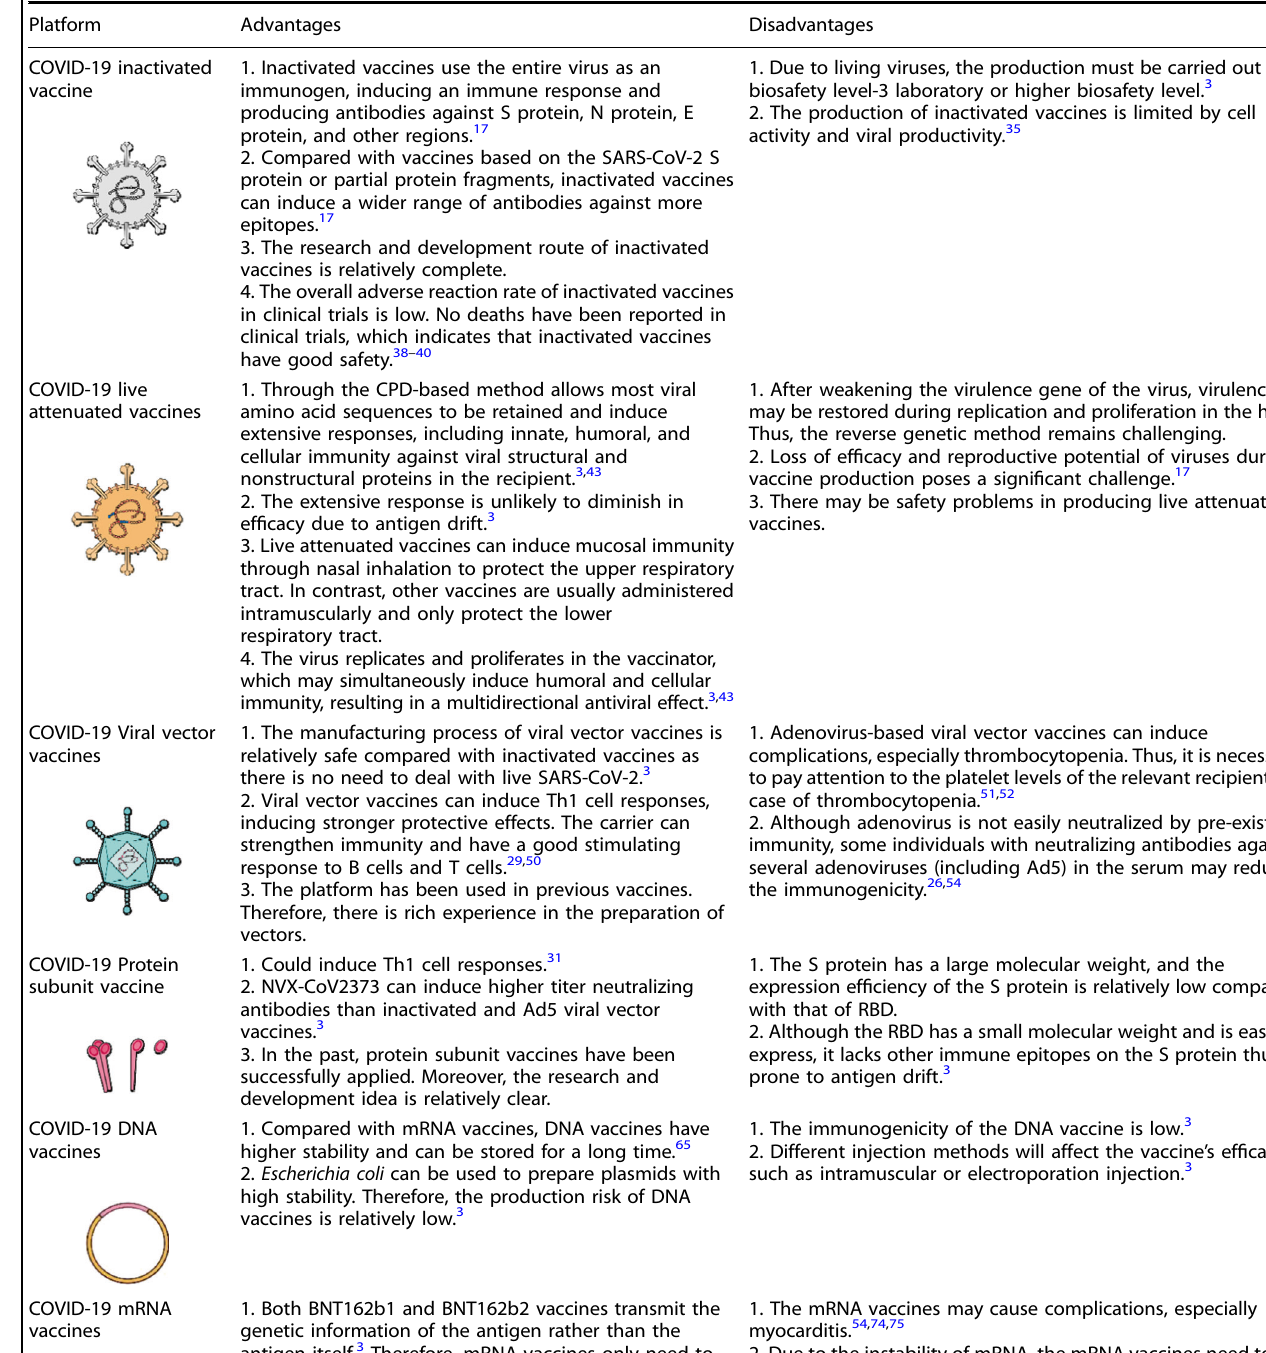
Table 2. Comparison of advantages and disadvantages of the COVID-19 vaccine Platform Advantages